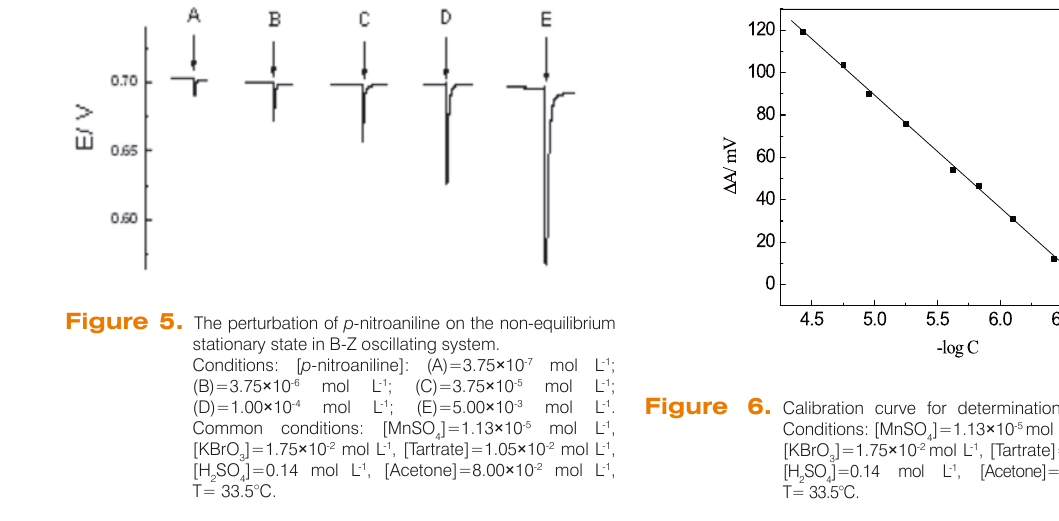
Fig. 5 showed the perturbation of different amount of p- nitroaniline on the system at the same temperature. A good linear range from 2.50×10 -7 to 3.75×10 -5 mol L -1 was obtained with a lower detection limit of 2.50×10 -8 mol L -1 (see Fig. 6). The linear relationship can be expressed by the following regression equation: